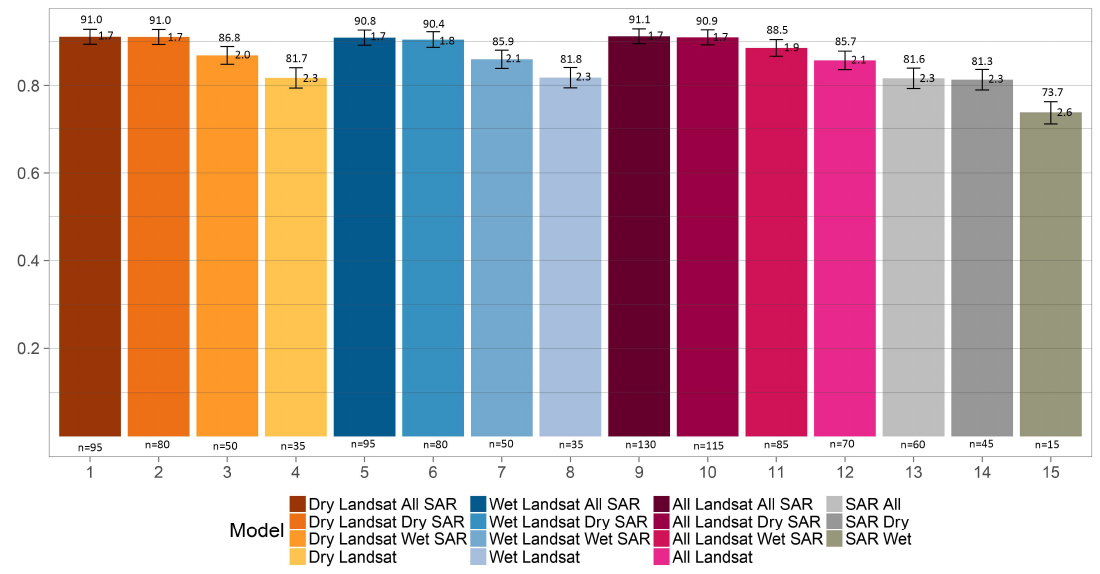
Figure 4. The overall accuracies and confidence intervals for the 15 land cover mapping model combinations tested. n : the number of variables in each model. Table 4. Confusion matrix and accuracy statistics for the all-parameter model (Model #9 in Table 3).